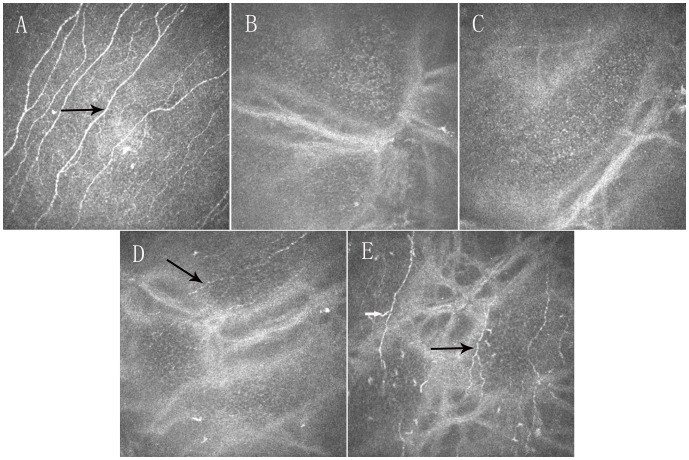
Confocal microscopy (HRT III) images showing time-dependent changes in the corneal subbasal nerve fibers in the central cornea in FS-LASIK group.Preoperatively (A), corneal nerves were evident with thick and regular appearance (black arrow). At postoperative 1-week (B) and 1-month visits (C), corneal subbasal nerve fibers were absent. At postoperative 3-month (D) and 6-month visits (E), subbasal nerve fibers were evident (black arrow). Note subbasal nerve fibers should be distinguished from dentric cells (white arrow) (images acquired from the same subject). Field size: 400 µm×400 µm.